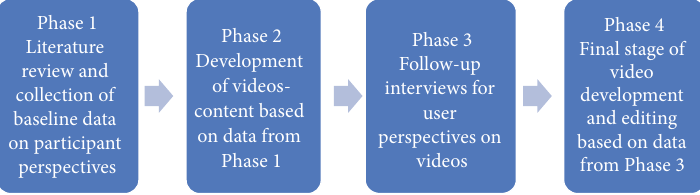
Figure 3: Action research process.